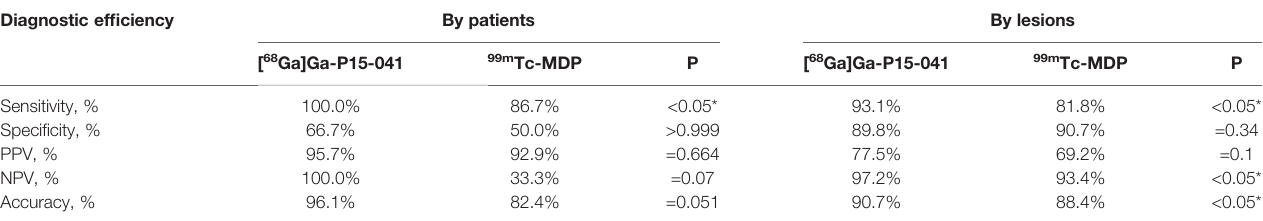
TABLE 4 | Comparison of Bone Metastases Detection Ef fi ciency Between 68 Ga-P15-041 PET/CT and 99m Tc-MDP WBBS Based by Patients and by Lesions. Diagnostic ef fi